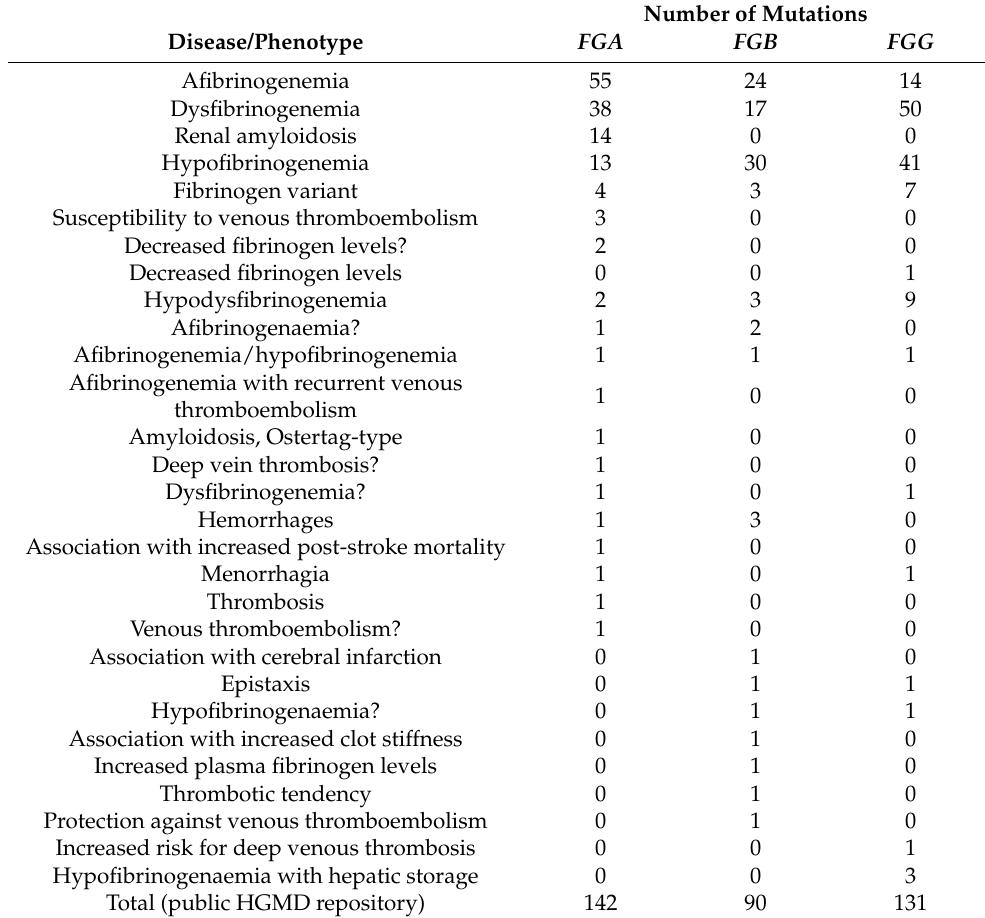
Table 4. Distribution of mutations in the FGA , FGB , and FGG genes according to the associated